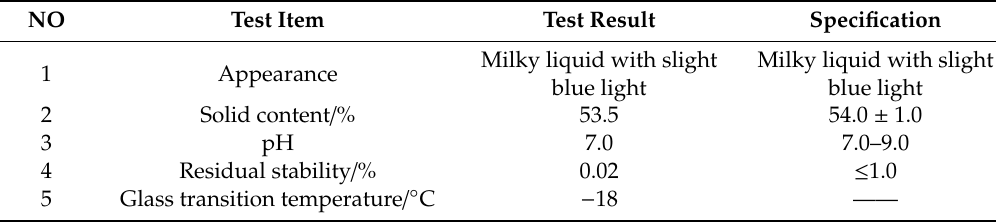
Table 3. Test results of the technical index of